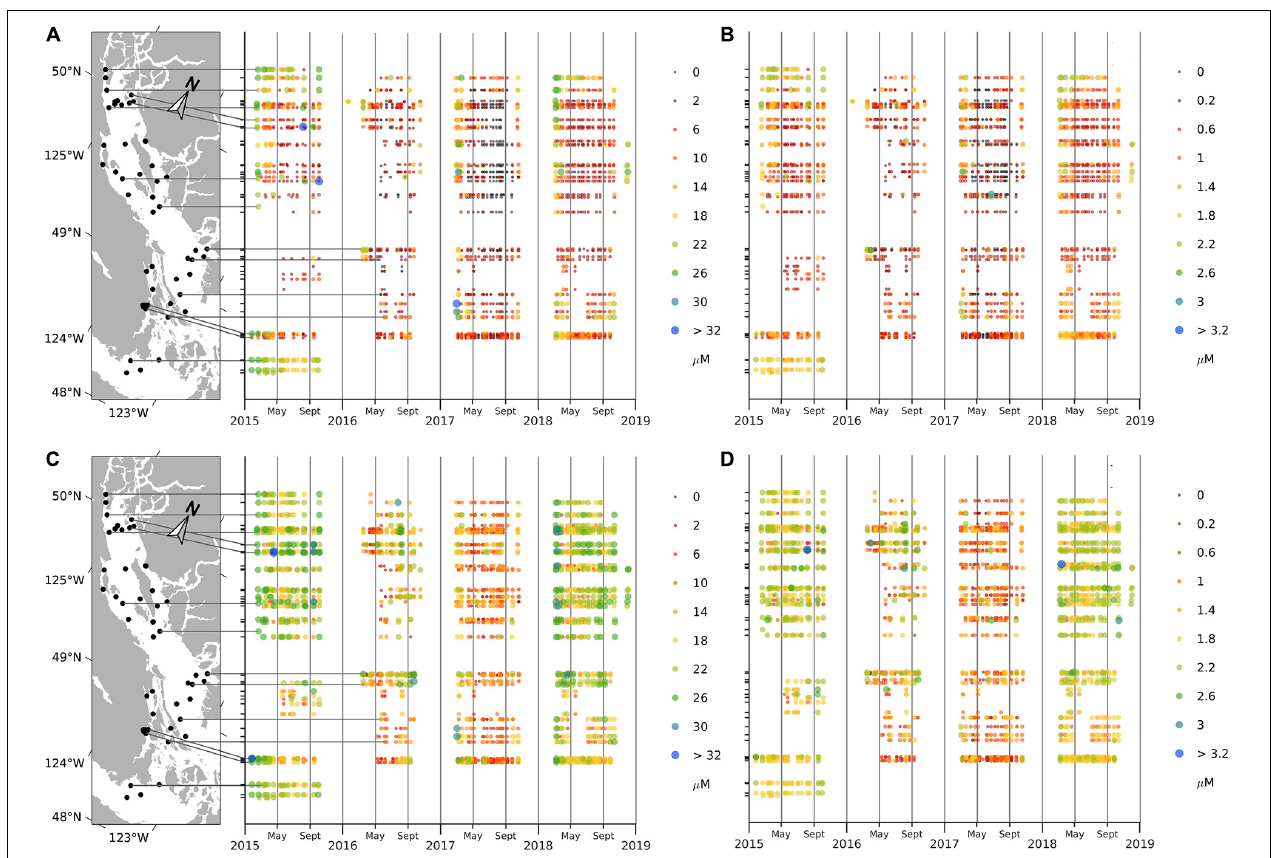
FIGURE 4 | Concentrations ( µ M) of nitrates (A) and phosphates (B) at the surface; nitrates (C) , and phosphates (D) at 20 m depth.